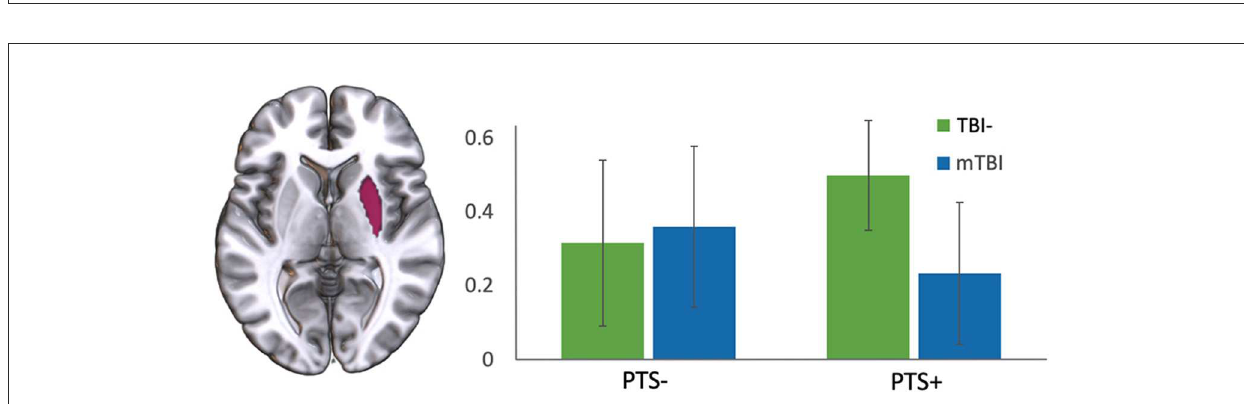
FIGURE8 Interaction of TBI with severity of PTS symptoms. There was an interaction of TBI group (TBI- vs. mTBI) and PCL-5 score (high vs. low) in the functional connectivity between right amygdala and right putamen. y-axis represents correlation coefficient.